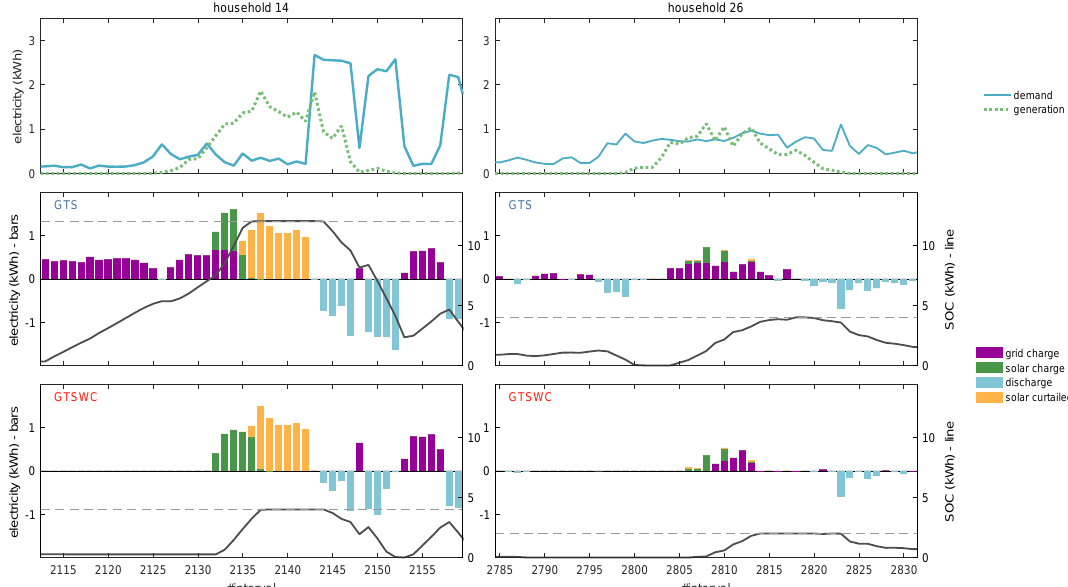
Figure 7. Demand, generation and battery usage. The demand and generation profiles of Household 14 ( left ) and Household 26 ( right ) for representative days are shown. Furthermore, the specific battery usage based on the GTS and GTSWC approaches is presented. For these four plots, the left-hand axes represent the electricity values for the bars, while the right-hand axes indicate the State-Of-Charge (SOC) of the respective battery. The dotted line indicates the optimal battery size for the respective household. For this particular day, Household 14 improved their self-consumption by 6.0% and 10.4% through the GTS and GTSWC approaches, respectively. Household 26 improved their self-consumption by 2.7% for both